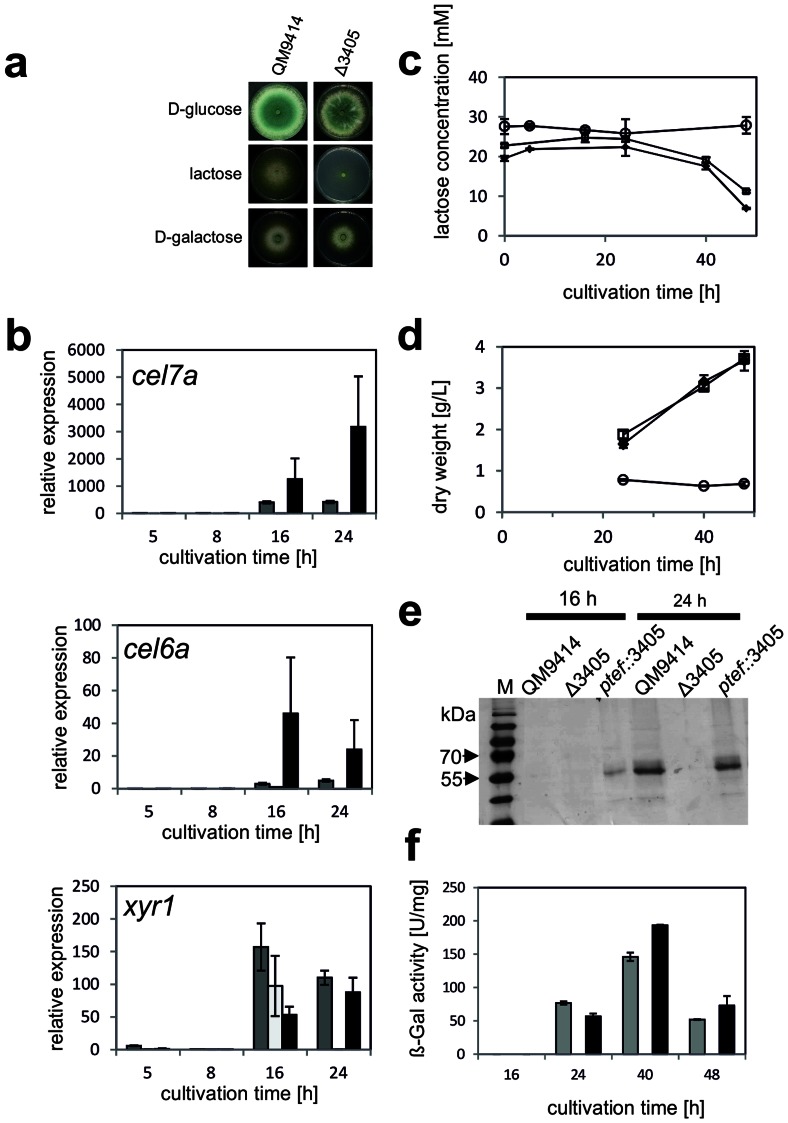
(a) Growth comparison of QM 9414 to the Δ3405 strain on minimal media supplemented with D-glucose, lactose and D-galactose. Pictures were taken on day 4. (b-g) Comparison of strains QM 9414 (grey), Δ3405 (white) and ptef::3405 (black) pregrown in minimal medium supplemented with 1% glycerol and,after washing of the mycelium extensivly with sterile water, transferred to minimal medium containing 1% lactose. (b) Accumulation of cel6a, cel7a and xyr1 transcripts measured by qPCR. Samples were taken 5, 8, 16 and 24 h after replacement to 1% lactose. The expression is given in relation to tef1 gene expression, where the tef1 expression value equals one. Mean values ± SD of three independent experiments are shown. (c) Lactose concentration in the medium during growth of QM 9414 (filled diamonds), Δ3405 (empty circles) and ptef::3405 (empty squares) on 1% lactose. (d) Biomass formation of strains QM 9414 (filled diamonds), Δ3405 (empty circles) and ptef::3405 (empty squares) on 1% lactose. Mean values ± SD of three independent experiments are given. (e) SDS-PAGE analysis of culture filtrates from QM 9414, Δ3405 and ptef::3405. Samples taken at 16 and 24 h after replacement to lactose. (f) ß-galactosidase activity determined with o-nitrophenyl-ß-D-galactopyranoside as the substrate. Error bars indicate the standard deviation of three independent experiments.